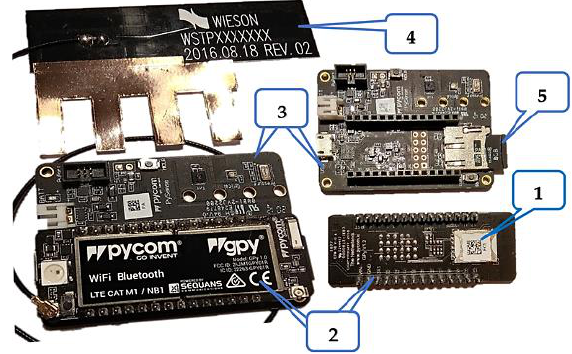
Figure 27. UBIRCH Testkit hardware Components.